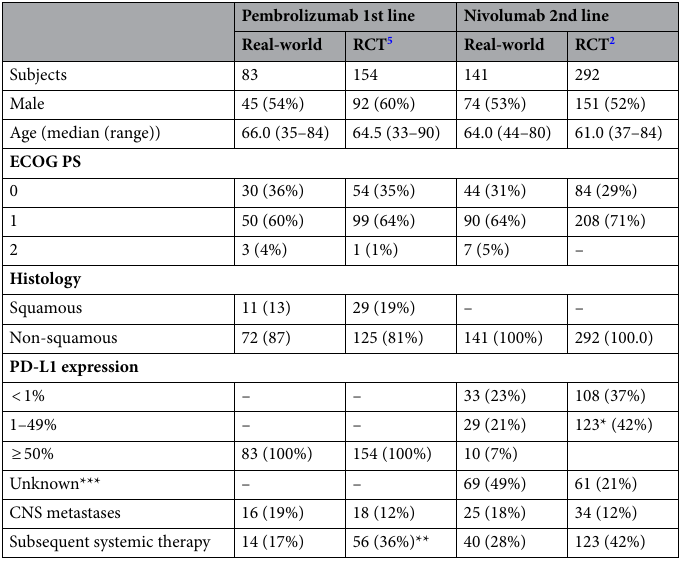
Table 1. Patient characteristics of stage IV NSCLC patients with 1L pembrolizumab or 2L nivolumab. ECOG PS, Eastern Cooperative Oncology Group Performance Status; CNS, central nervous system; RCT, randomized clinical trial. *PD-L1 expression of ≥ 1%. **Including surgery and radiation therapy. ***Not performed in real- world; not quantifiable from RCT 2 .